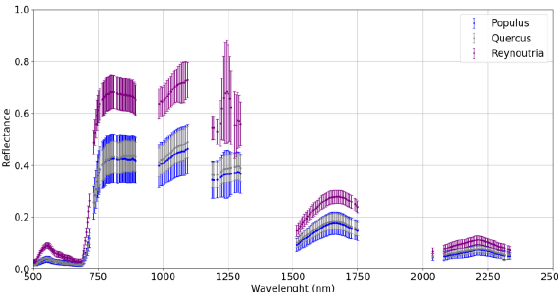
Figure 3 . Mean spectrum and intra-class standard deviation for the two most distant classes and the two closest classes in Euclidean distance.